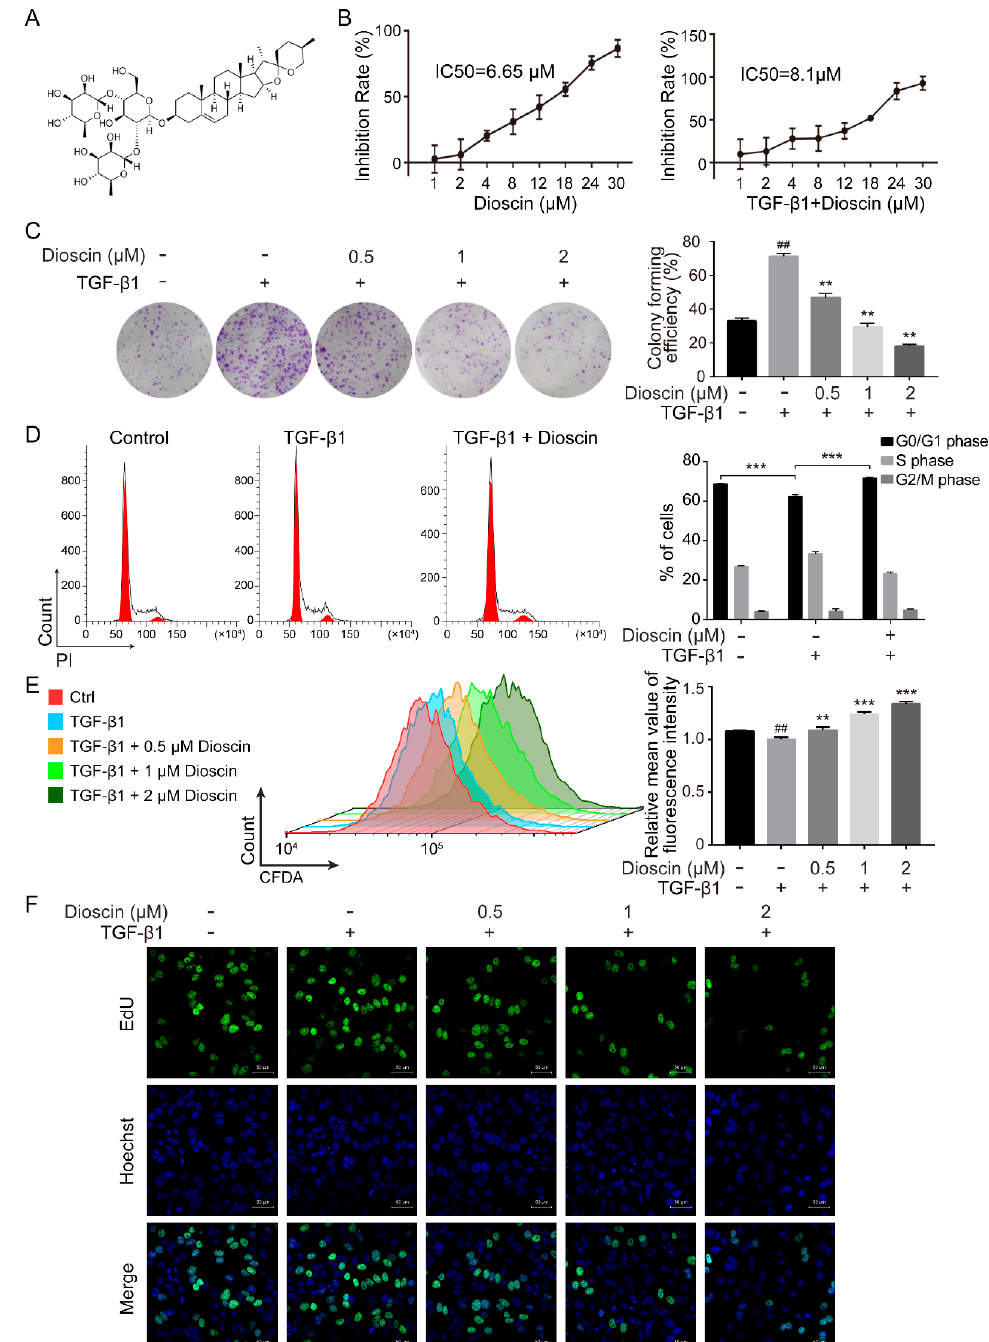
Figure 1. Dioscin inhibits the proliferation of HepG2 cells. ( A ) The molecular structure of dioscin. ( B ) Dioscin inhibits the viability of HepG2 cells, as determined by the CCK8 assay. The inhibitory concentration (IC50) was calculated using GraphPad Prism 6.0 software. ( C ) Dioscin inhibits the colony formation of HepG2 cells. ( D ) Cell cycle distribution of HepG2 cells treated with dioscin was analyzed by flow cytometry. ( E ) Dioscin inhibits the division of HepG2 cells. Drug-treated cells were stained by CFDA-SE and analyzed by flow cytometry. ( F ) Dioscin inhibits the DNA synthesis of HepG2 cells. Drug-treated cells were labeled with EdU. The EdU-positive cells are marked in green; Hoechst 33,342 (blue) was used for nuclear staining. Images were acquired using a confocal laser scanning microscope. The scale bar represents 50 µ M. Cells were treated with 5 ng / mL TGF- β 1 for 24 h. ## p < 0.01 vs. control group; ** p < 0.01 and *** p < 0.001 vs. TGF- β 1-induced